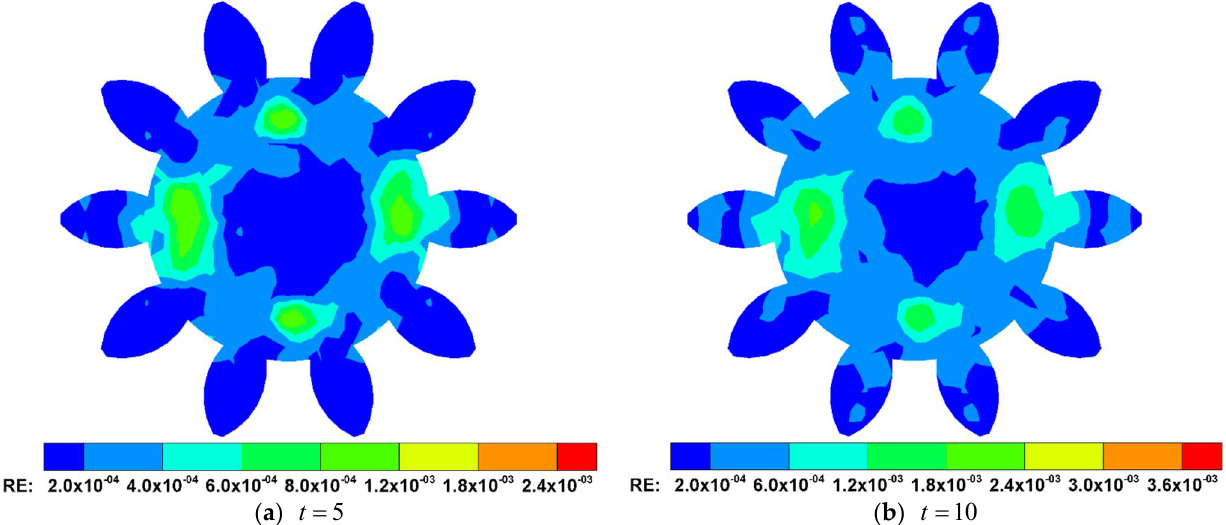
Figure 13. The contours of relative errors of hydraulic head H at t = 5 and t =